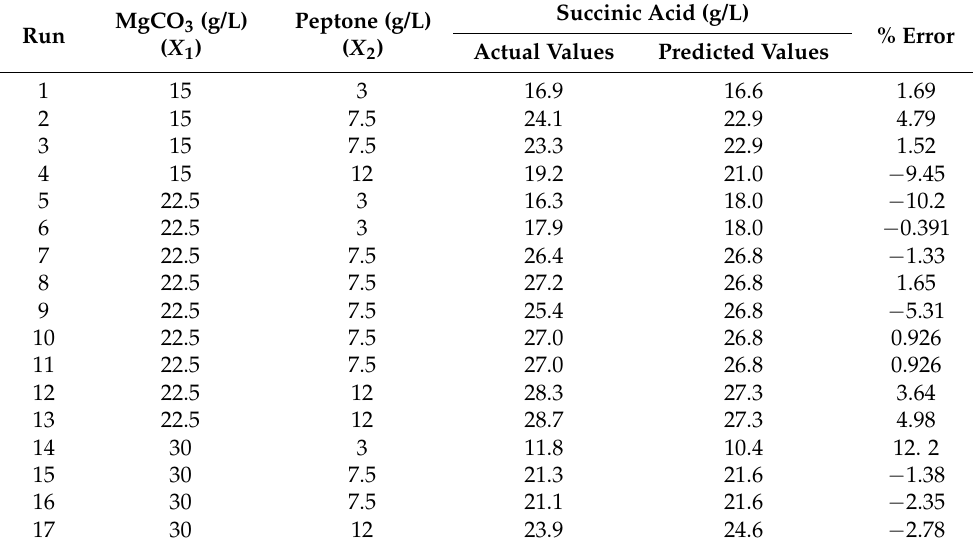
Table 5. Experimental and predicted values of succinic acid by E. gallinarum using BBD. MgCO 3 (g/L) Peptone (g/L) Run